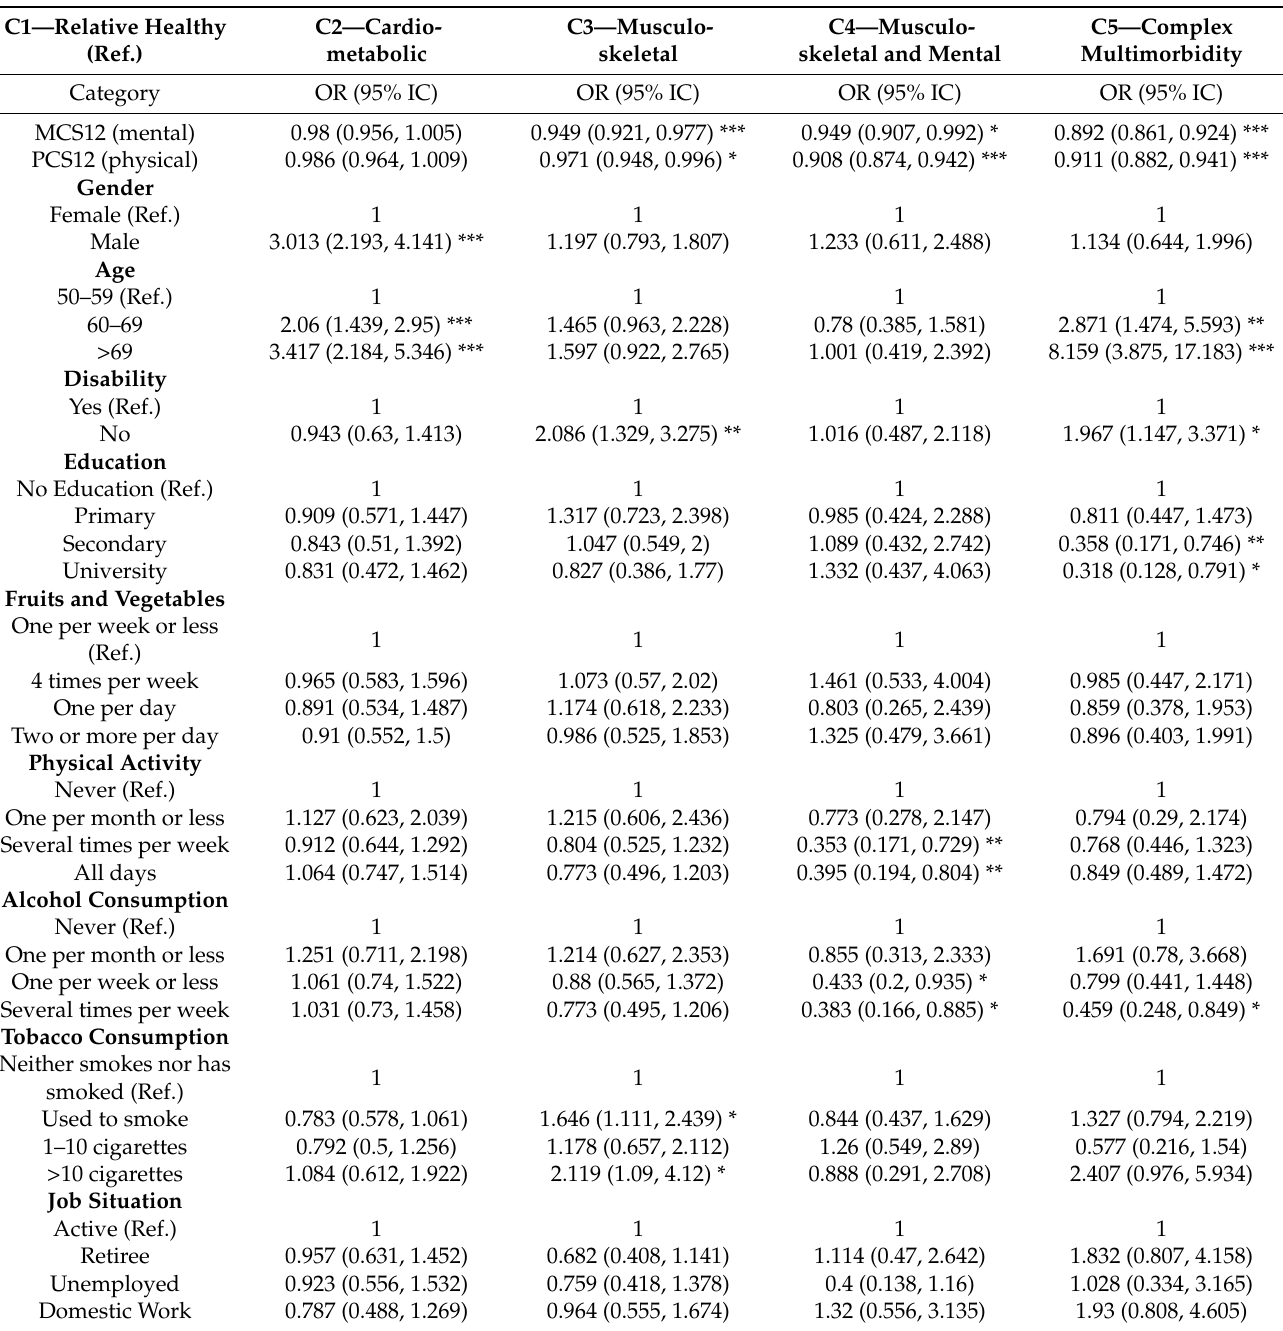
Table 3. Multinomial Logistic Regression of social determinants associated with patterns of chronic conditions. OR referred to Relative Healthy